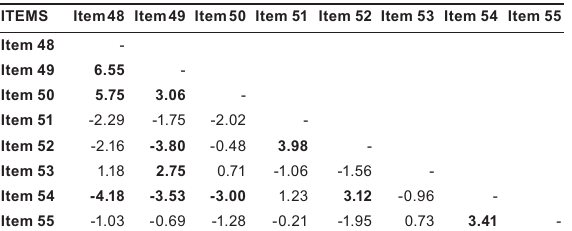
Standardised residuals for Service dimension – Mall intercept ITEmS